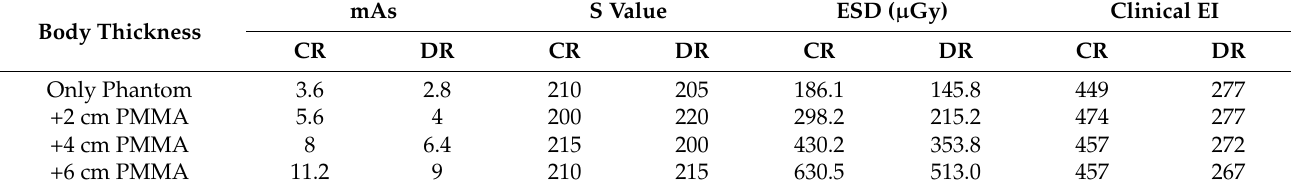
thickness and the ESD, S value, and EI. Table 3. Result of tube current time product, S value, entrance surface dose, and clinical exposure index for chest radiography (PA projection).